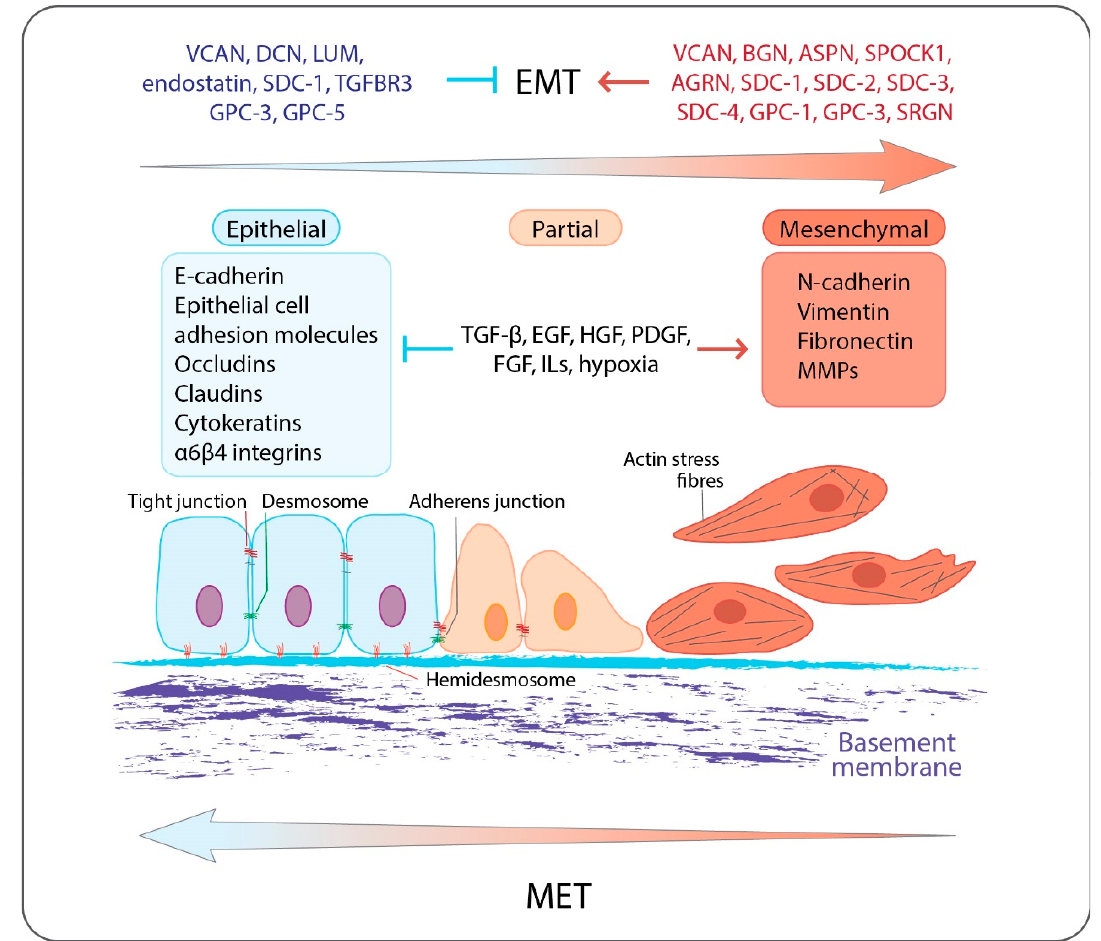
Figure 1. Overview of EMT: epithelial cells are anchored to the underlying basement membrane by hemidesmosomes and are interconnected by tight junctions, adherens junctions, and desmosomes. They express specific cell surface and cytoskeletal proteins associated with epithelial phenotype such as E-cadherin, epithelial cell adhesion molecules, occludins and claudins, epithelial cell-associated integrins α 6 β 4, and cytokeratins. EMT is triggered by numerous growth factors, cytokines, and hypoxia, which activate a transcription program, which is associated with the inhibition of the expression of epithelial-related genes and the induction of the expression of mesenchymal-related genes including N-cadherin, vimentin, ECM molecules, fibronectin, and MMPs. Mesenchymal cells display increased motility and invasiveness. Epithelial cells during their progressive transition to a mesenchymal phenotype acquire an intermediate state (partial EMT), into which cells exhibit a mixed cell phenotype expressing both epithelial and mesenchymal markers. PGs are involved in the EMT program affecting, among others, EMT-related signaling pathways acting either as inducers or as inhibitors. EMT can be reversed where the mesenchymal cells can revert to the epithelial phenotype by undergoing MET. Both EMT and MET occur during cancer progression and the development of distant metastases.